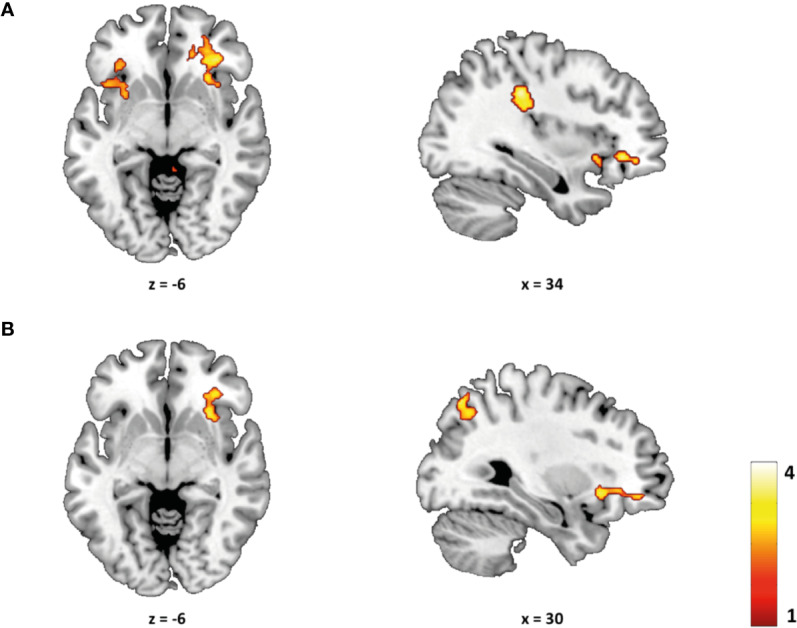
Group differences (BD > CN) during successful inhibition. (A) Compared to controls, BDs showed a greater BOLD activity in the NoGo vs. Go contrast in the bilateral inferior frontal gyrus, extending to the anterior insula (BA 47) (p <.05 FWE-small volume corrected). (B) BDs, in comparison with controls, showed a greater BOLD activity in the NoGo Alcohol vs. Go Non-Alcohol contrast in the right inferior frontal gyrus/anterior insula (BA 47) (p <.05 FWE-small volume corrected). T-maps are thresholded at p <.005 (uncorrected) and k ≥ 150 for display purposes only.